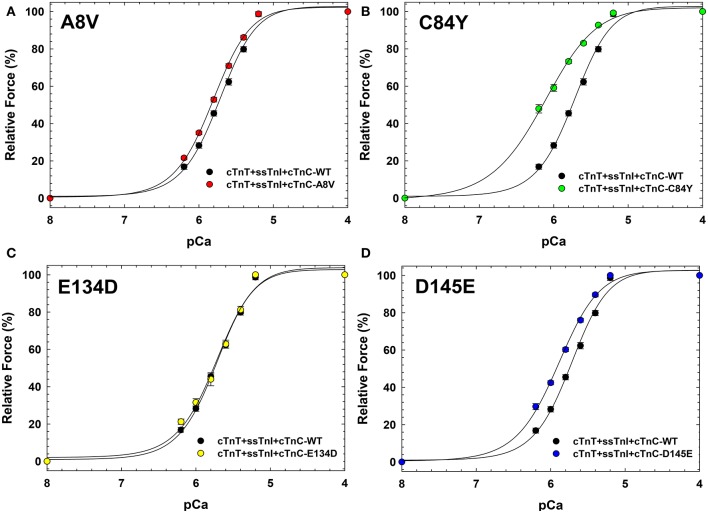
Ca2+ dependence of steady-state isometric force development in porcine cardiac preparations reconstituted with slow skeletal TnI together with WT cTnC or cTnC HCM mutants. Comparisons of Ca2+ sensitivity of force development obtained for cTnC WT and HCM mutants, in (A) WT vs. A8V, (B) WT vs. C84Y, (C) WT vs. E134D, and (D) WT vs. D145E. Regression parameter estimates of pCa50 and nHill, along with ΔpCa50 and relative maximal force values for these experiments are summarized in Table 3. Data are shown as mean ± S.E.M.